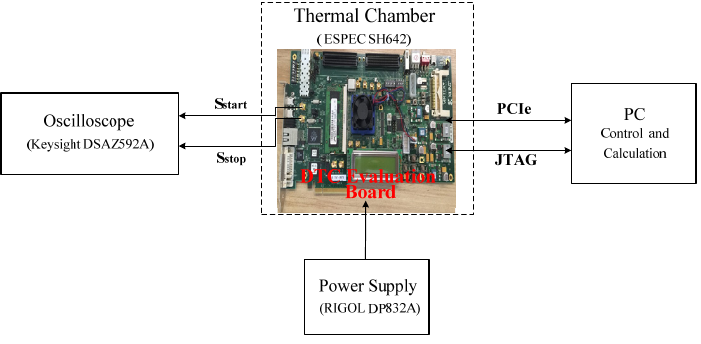
Figure 8. Test system of the DTC.